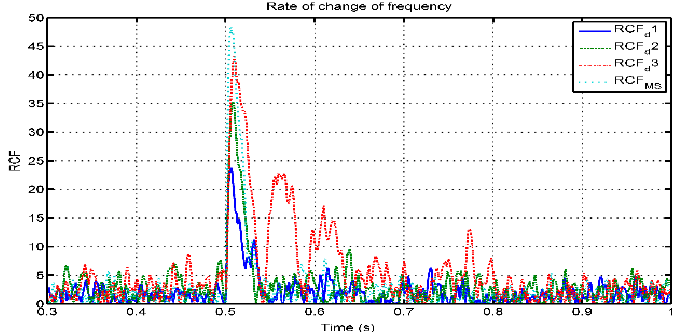
Figure 18. RCF comparison (VSG-3).